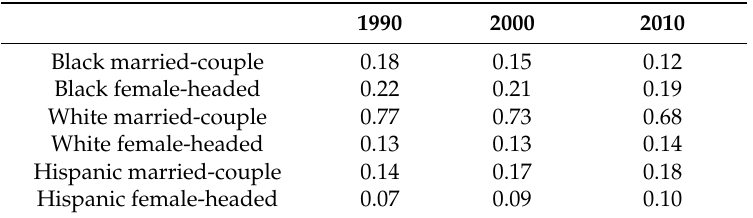
Table 1. Average Isolation Index score for 85 metropolitan areas with at least 500 households in each category, using Census 1990–2010 from the